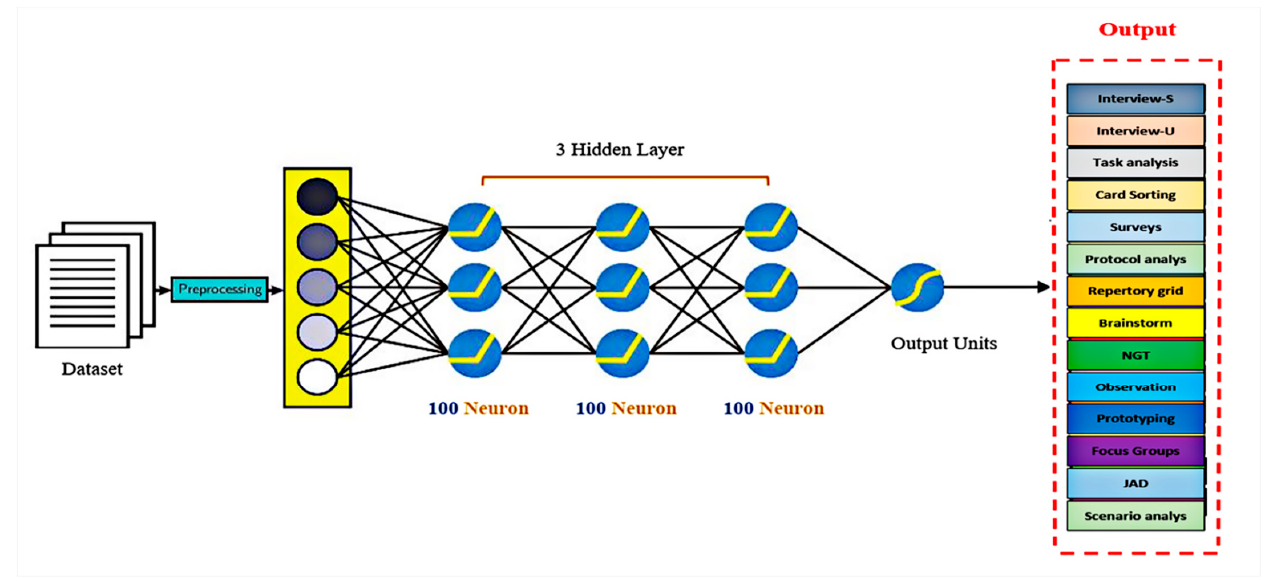
Figure 2. Deep learning model